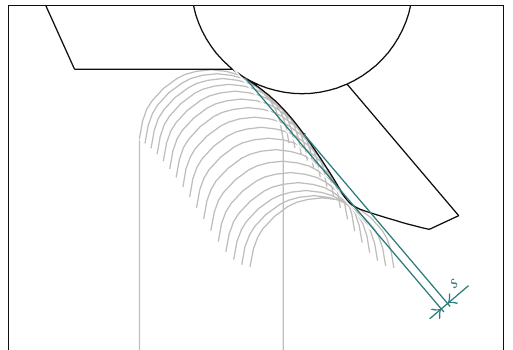
Figure 3: Computer simulations show that the ideal profile of the incisal table should not be flat: the curvature is more noticeable near the position of intercuspal